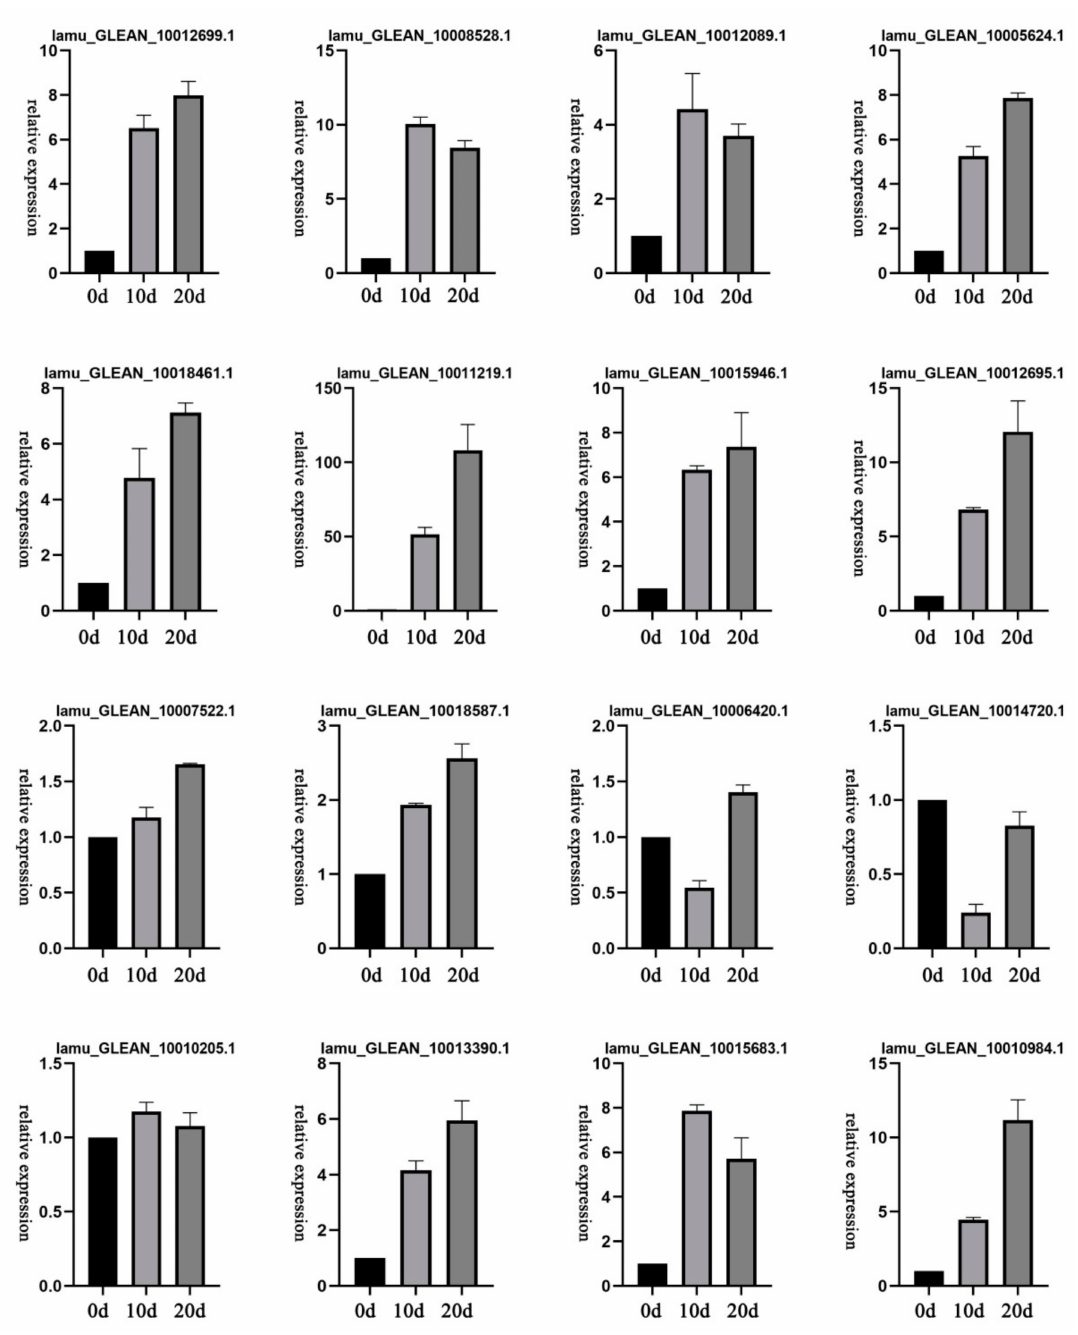
Figure 7. Expression level validation by qRT-PCR for selected genes in three